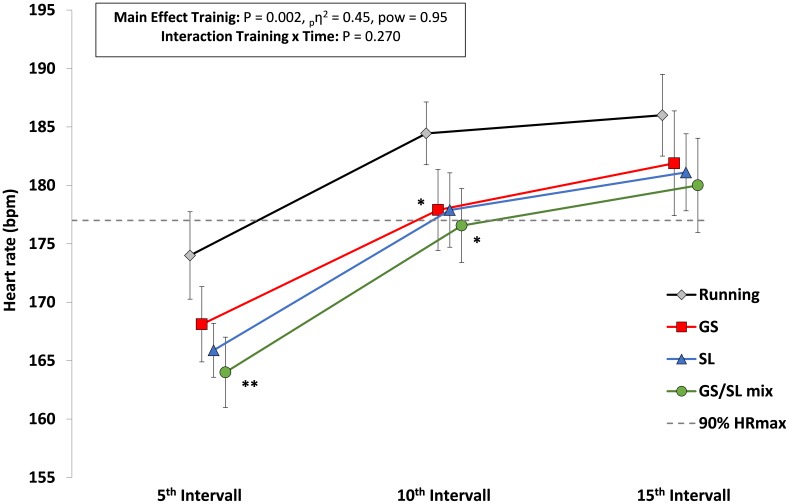
Peak heart rate values within interval 1–5 (5th interval), 6–10 (10th interval), and 11–15 (15th interval) for the four HIT protocols with running, giant slalom mode (GS), slalom mode (SL), and the mixed GS/SL mode. ∗P < 0.05, ∗∗P < 0.01, significant different to running; pη2, partial eta square effect size; pow, statistical power; and mean ± SD.